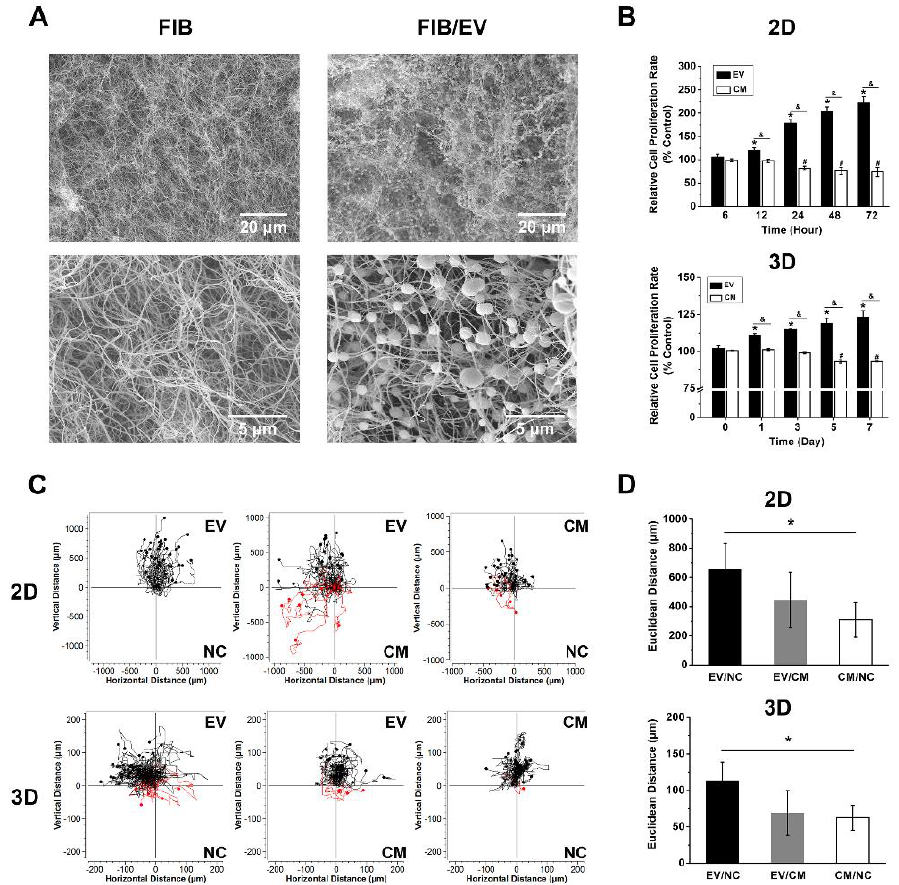
Figure 3. The evaluation of EV-loaded fibrin gel and its effect on cell proliferation and migration. ( A ) SEM images of fibrin gel surface and EV-loaded fibrin gel surface. ( B ) Histograms of cellular proliferation in monolayer and fibrin gel as determined by XTT assay. Please note that the 3D system comprises a co-culture of HUVEC and DPSCs with an equal number. (* p < 0.05 between EVs treated group and control, # p < 0.05 between CM treated group and control, & p < 0.05 between EVs and CM treated group). ( C ) Images of the plotted cellular migration path as determined by chemotaxis assay. The black lines present the HUVEC pathways towards the upper chamber (experimental group), while the red lines show the movement to the lower chamber (control). Data quantified from the experiment are shown in ( D ). The mean and standard deviation of triplicate experiments are plotted. * p <